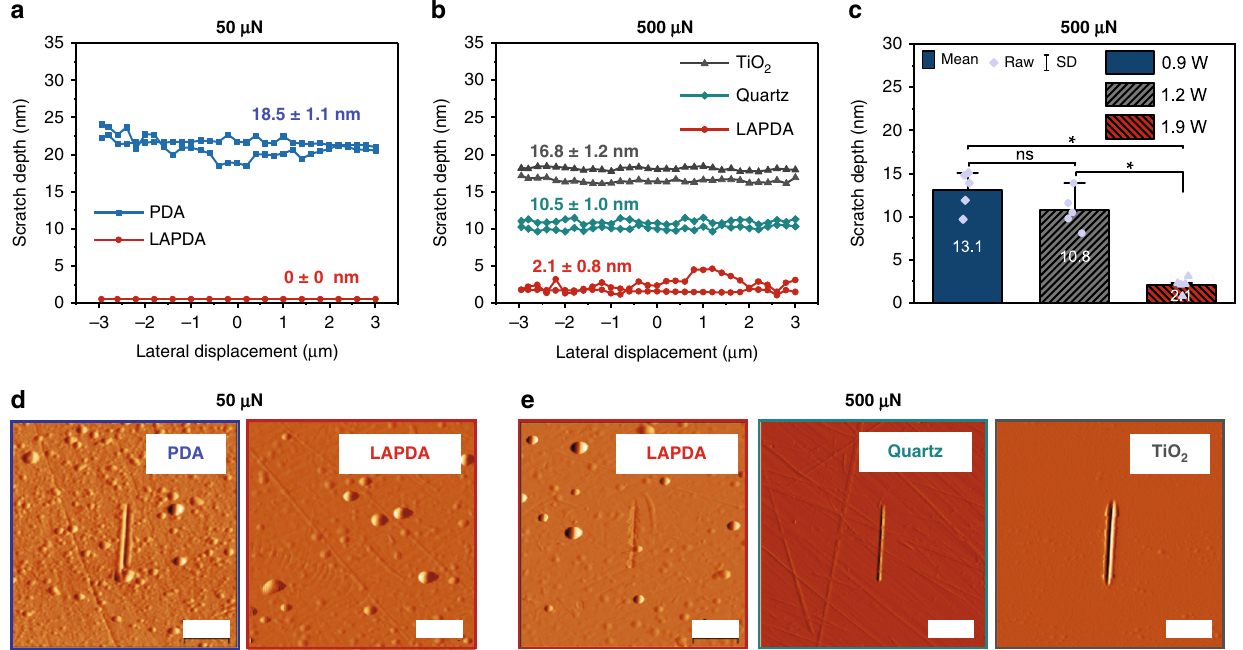
Fig. 2 Scratch resistance measurements on pristine PDA fi lm, LAPDA fi lm, and inorganic substrates. Representative scratch depth – lateral displacement curves at a 50 µ N and b 500 µ N, respectively. c Scratch depths for LAPDA fi lms annealed at 0.9, 1.2, and 1.9 W were compared. Bars represent mean values and original data points overlaid as purple dots; error bars represent standard deviation. Statistical signi fi cance (asterisk symbol) was assessed using a one-way analysis of variance with Tukey ’ s post-test ( n = 5). d , e Corresponding scratched images on the substrates of ( a, b ). The scale bar is 2 µ m. Source data are provided as a Source Data fi